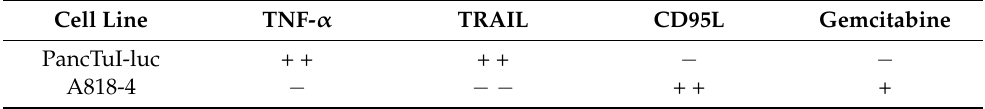
Table 1. Sensitivity of PDAC Cells towards death receptor ligands and Gemcitabine. Cell Line TNF- α TRAIL CD95L Gemcitabine PancTuI-luc + + + + −